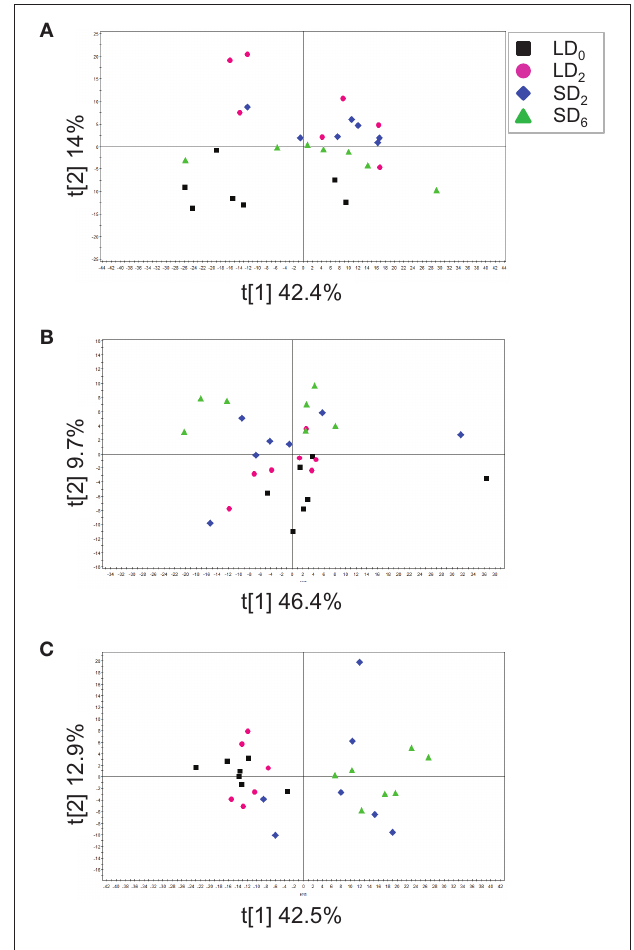
FiGure A1 | The PCA score scatter plot of leaf 2 (A), leaf 10 (B), and leaf 20 (C) samples under different photoperiods. Black square, LD ; pink circle, 0 LD ; blue diamond, SD ; green triangle, SD . t[1] and t[2] present the first and 2 2 6 second components and each percentage shows the fraction of the sum of squares for the selected component. We excluded a leaf 20 sample grown under the LD condition because the sample was identified as an outlier in the 2 score and Hotelling’s T